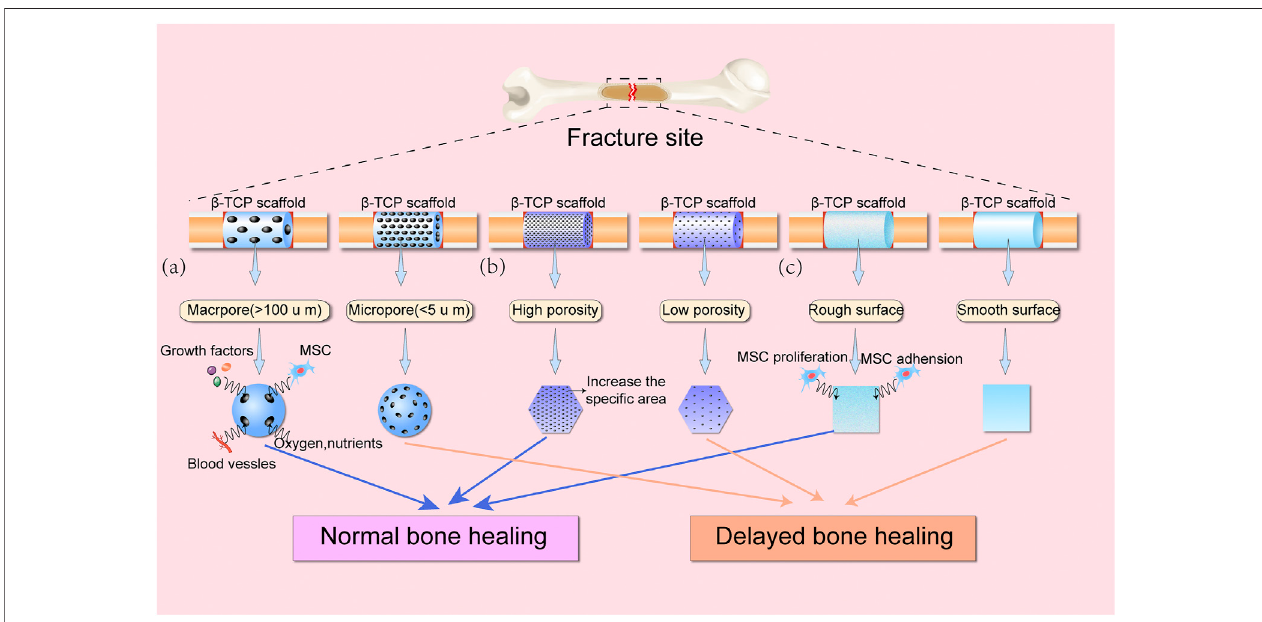
FIGURE 1 | Schematic diagram showing the effects of various physical features of β -TCP scaffolds on bone healing. (A) Macropores ( > 100 μ m) provide greater space for access of growth factors, MSCs, blood vessels, oxygen, and nutrients into β -TCP scaffolds compared with micropores ( < 5 μ m). (B) High porosity can signi fi cantly increase the speci fi c areas of β -TCP scaffolds, as compared to β -TCP scaffolds with low porosity. (C) Rough surface of β -TCP scaffolds can improve MSC adhesion and proliferation, thereby promoting bone regeneration.